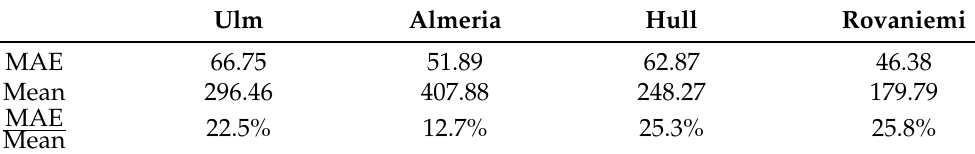
Table 5. MAE of the LSTMconv network and the mean global irradiation per hour. Ulm Almeria